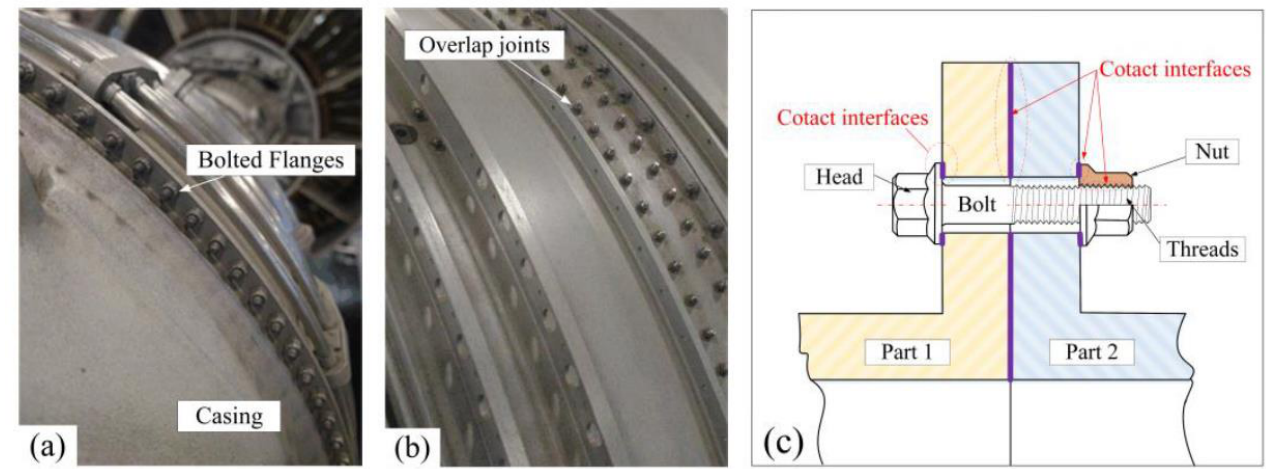
Figure 1. Illustration of bolted joints, ( a ) bolted flanges, ( b ) overlap joints, ( c ) the contact interfaces.